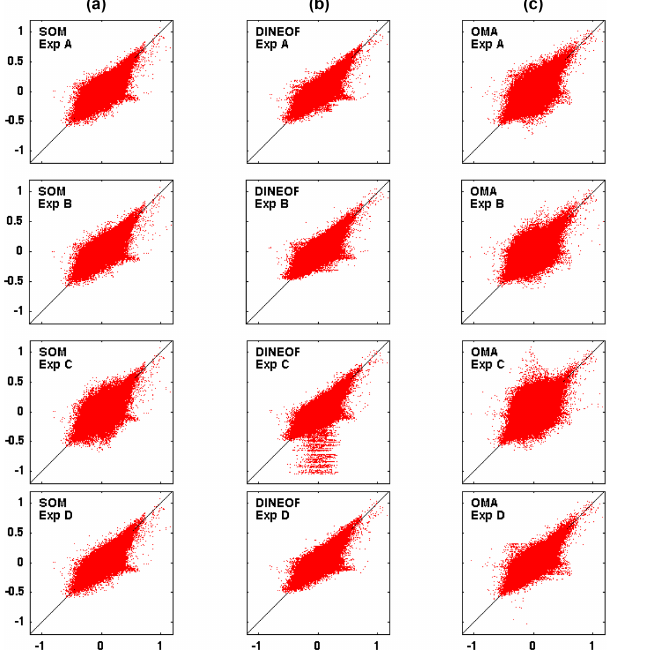
Figure 5. Scatterplot of the SOM (a) , DINEOF (b) and OMA (c) reconstructed zonal velocities vs. observations for the four experi- ments (rows).